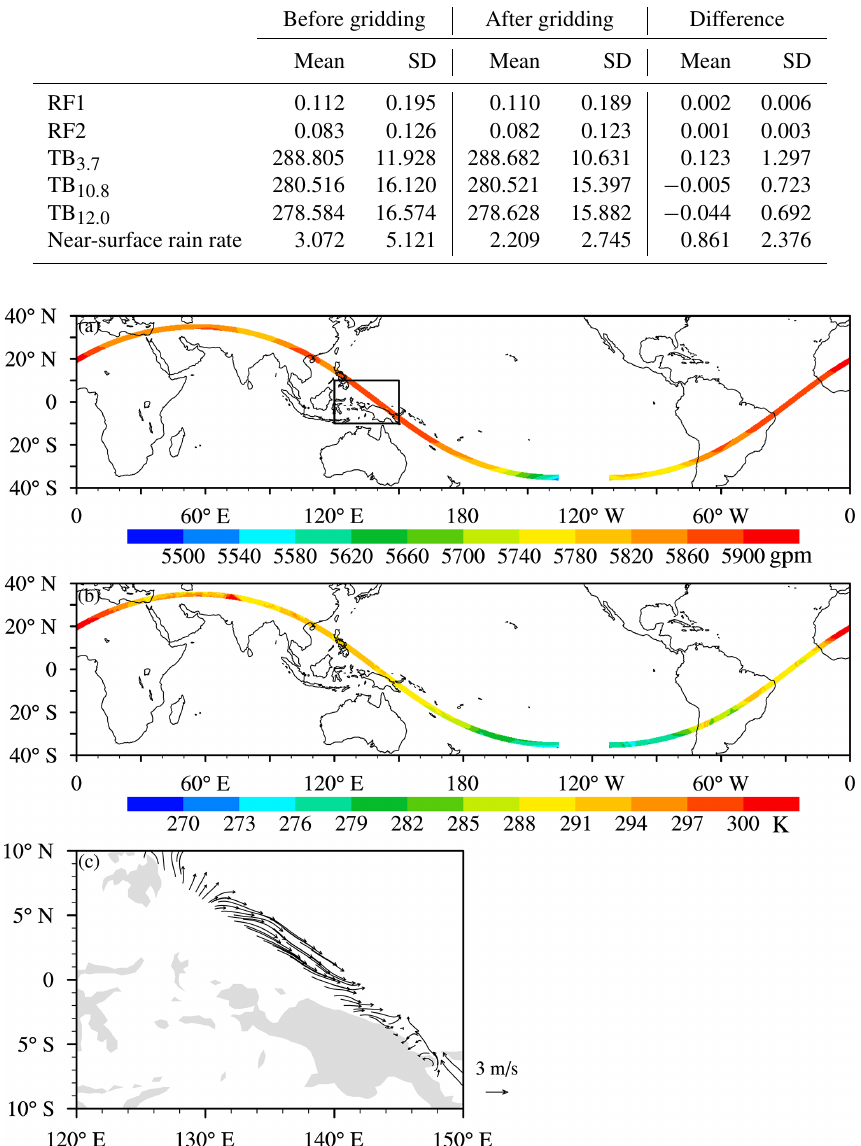
Figure 4. Distribution of (a) the geopotential height at 500hPa, (b) the temperature at 850hPa and (c) the wind field at 1000hPa for orbit number 37362 on 5 June 2004 in